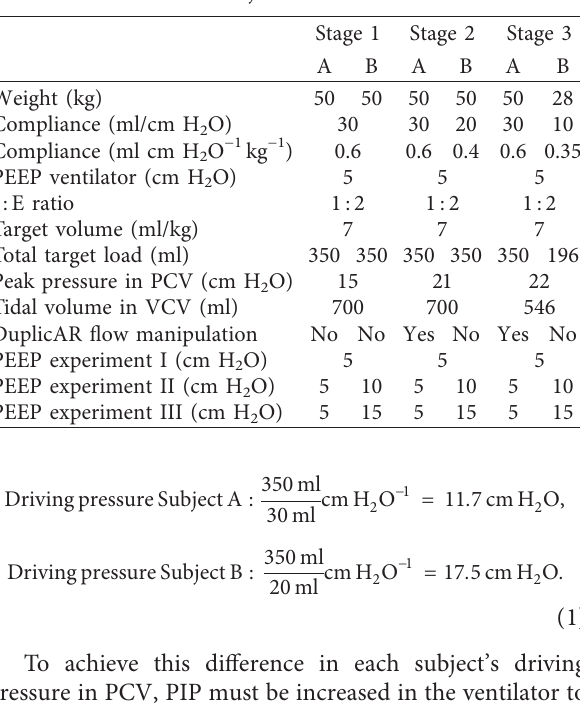
Table 1: Summary of the three stages, simulating the different possible combinations of subjects’ weights and lung compliances. The ventilator is configured in each mode to adequately ventilate the two subjects with a target volume of 7ml/kg. The controllers of the DuplicAR Ⓡ device are manipulated to deliver asymmetric flow or different PEEP to the